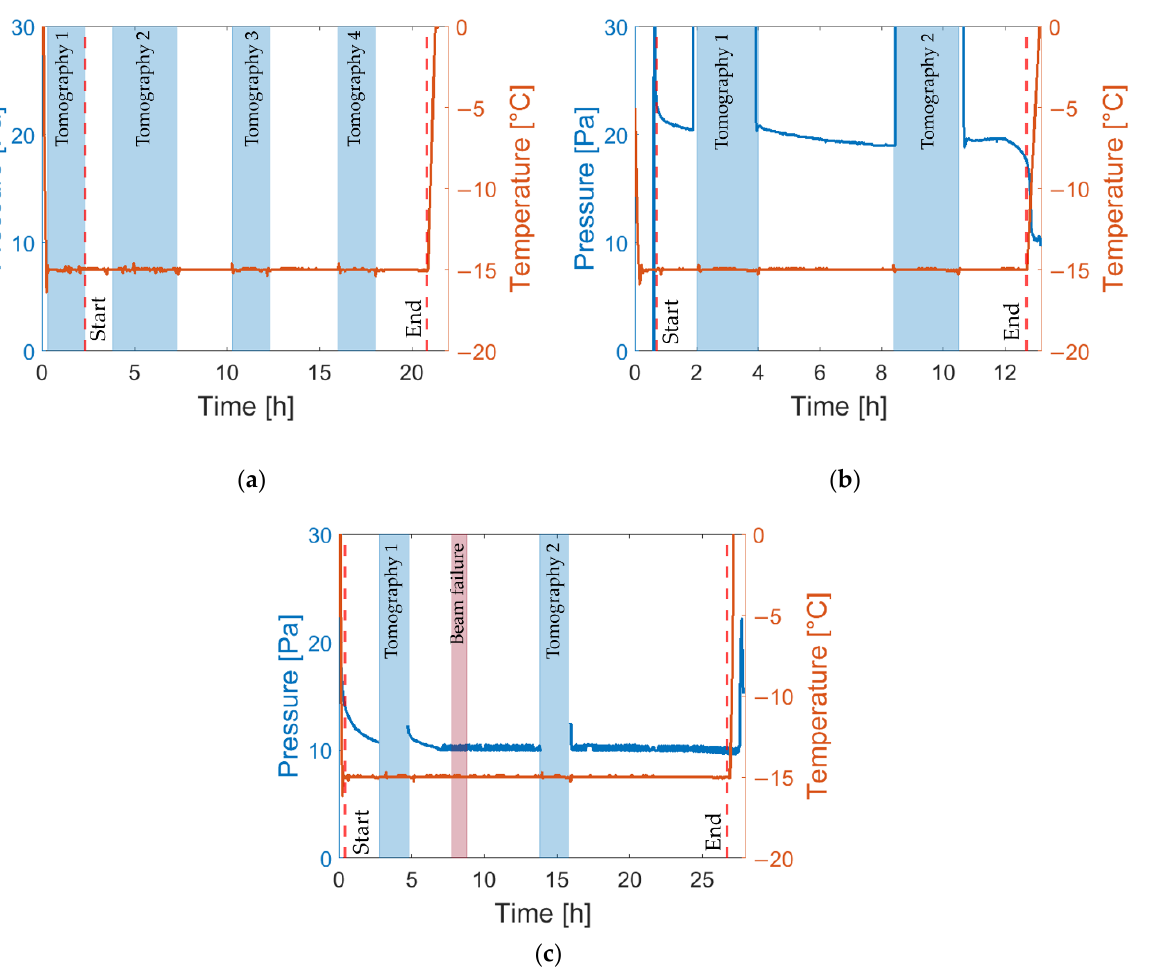
Figure 4. Pressure (blue lines) and temperature (red lines) profiles of ( a ) MD5, ( b ) MD5 AN and ( c ) MD30. The vertical dashed red lines indicate start and end of freeze-drying.